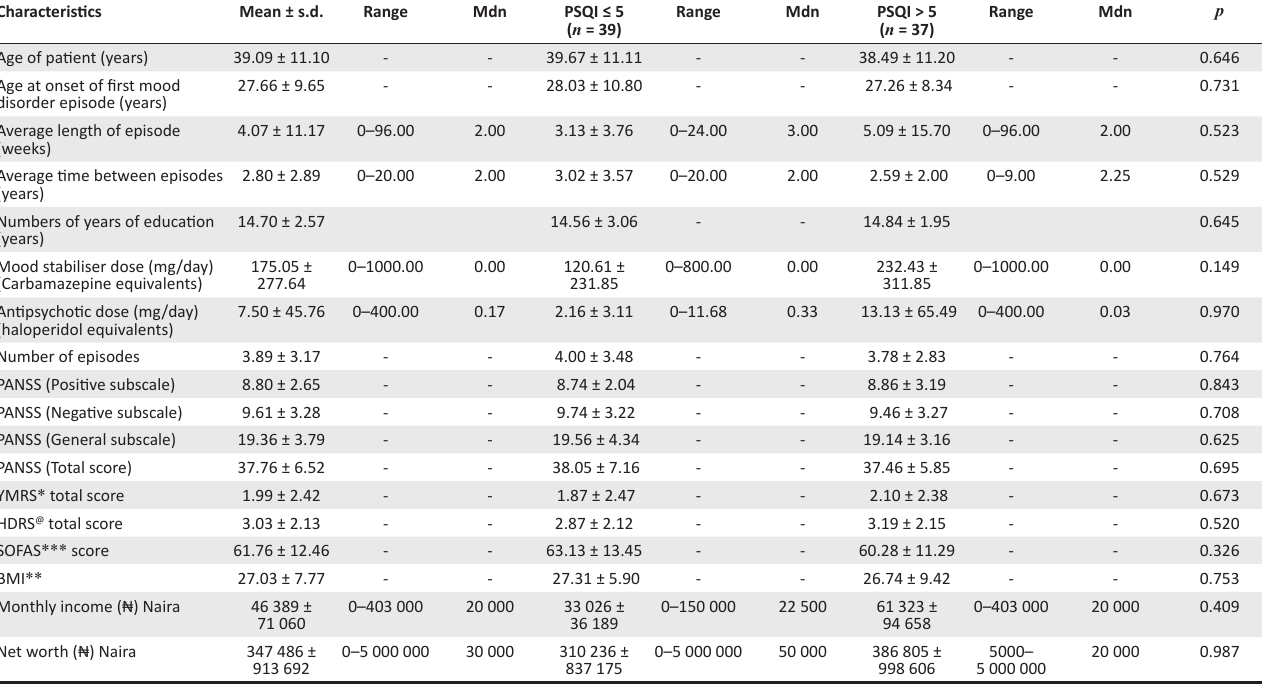
TABLE 1a: The sociodemographic and clinical characteristics of participants and comparison of clinical features of bipolar disease according to Pittsburgh Sleep Quality Index scores.